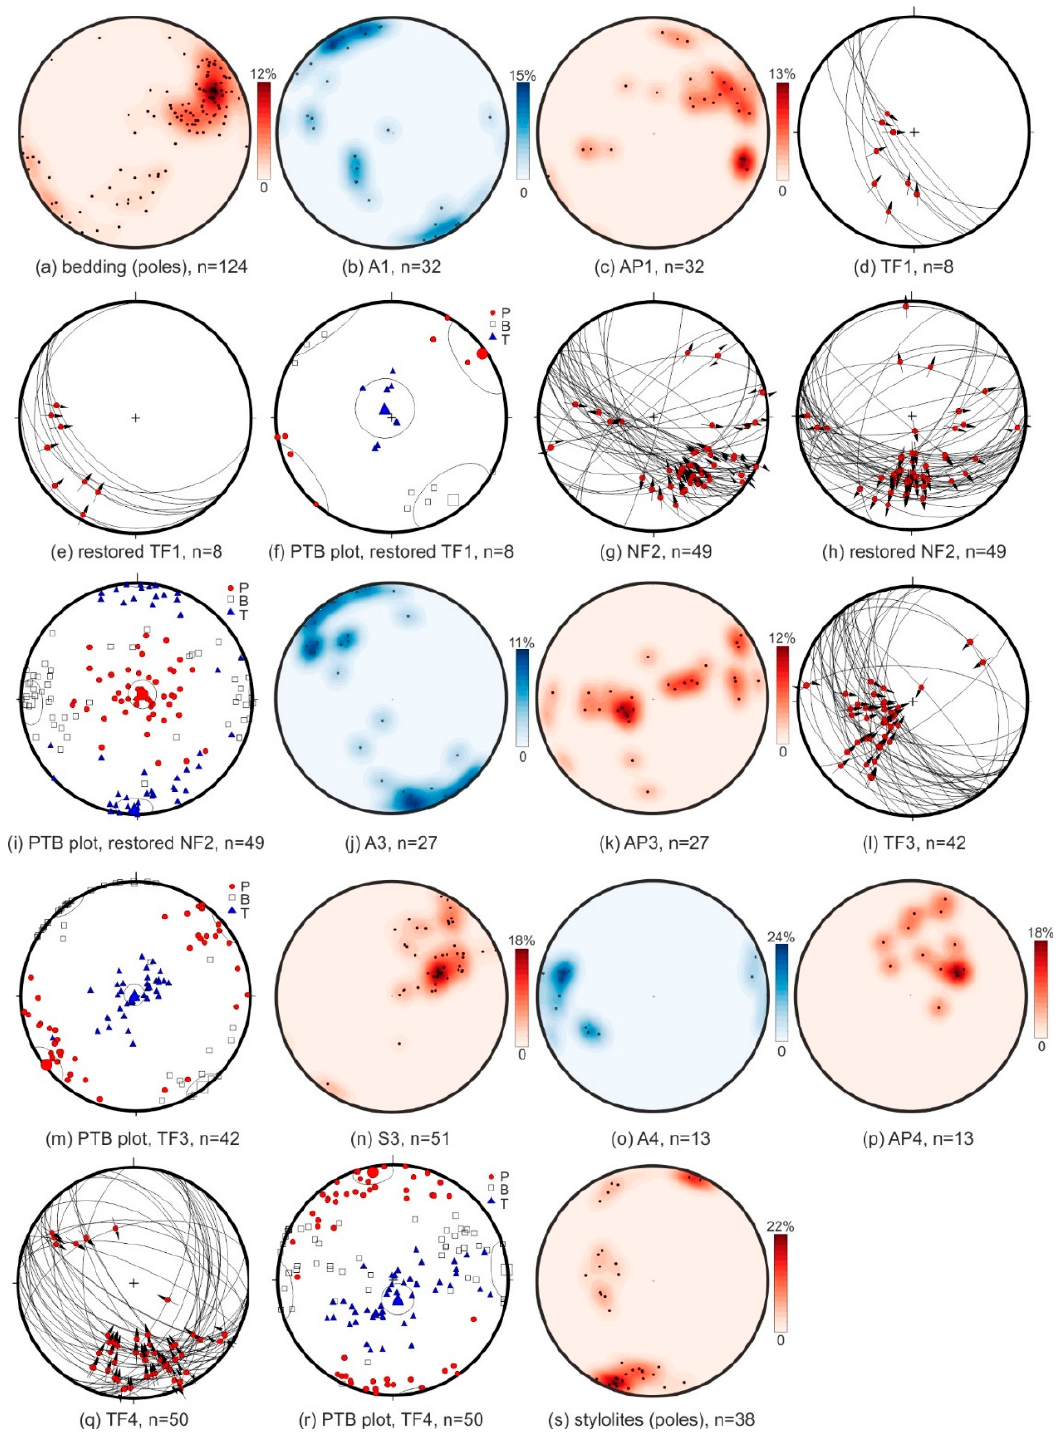
Figure 7. Salitto (Campagna tectonic window). ( a – s ) Stereographic projections (lower hemisphere, equiareal net) and PBT plots of the analyzed structures described in the text. A—fold axis; AP—axial plane; NF—normal fault; TF—thrust fault. S—tectonic foliation. Color bar indicates the density percentile of the contour plot. ( f ) θ = 30°; mean vectors; P: 055/04 (R = 85%); T: 143/11 (R = 83%); B: 324/82 (R = 87%). ( i ) θ = 44°; mean vectors; P: 076/86 (R = 74%); T: 268/09 (R = 65%); B: 181/03 (R = 75%). ( m ) θ = 54°; mean vectors; P: 232/03 (R = 75%); T: 144/02 (R = 80%); B: 316/88 (R = 87%). ( r ) θ = 40°; mean vectors; P: 349/06 (R = 70%); T: 085/01 (R = 50%); B: 166/76 (R = 68%).